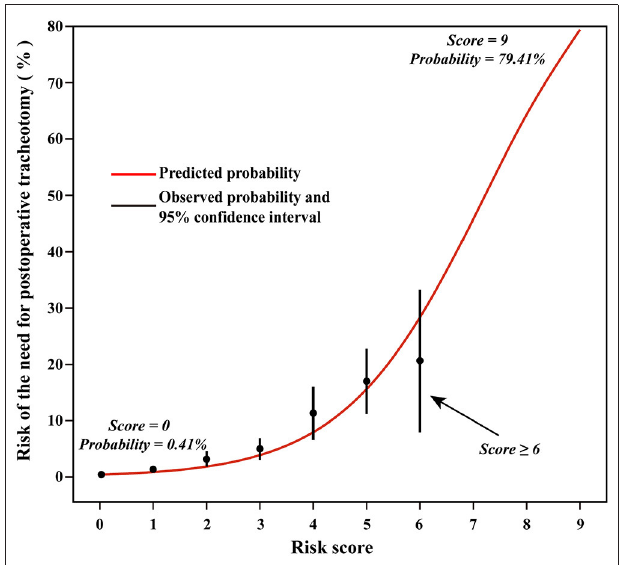
FIGURE 2 | Predicted rates of the need for postoperative tracheostomy based on the risk score model.